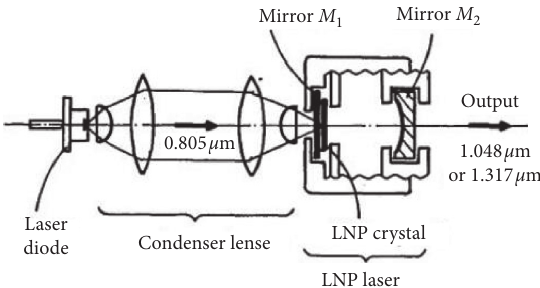
Figure 3: Structure of LD-pumped LiNdP operation